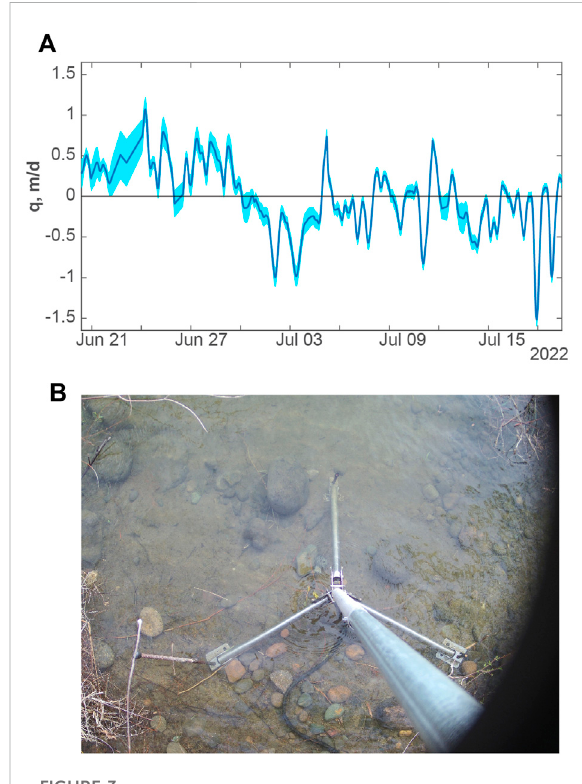
FIGURE 3 (A) AsubsetofERTSS fl uxestimates(darkblueline)asspeci fi c dischargeand95%con fi denceinterval(cyan)showing fl uctuations and reversals in fl ux. Downwelling is positive, and upwelling is negative. The con fi dence interval expands in width in between sample times as a function of sensitivity or changing measurement interval; this is evident during data gaps (e.g., there are several gaps during June 23 – 24). (B) Visual-light image of the IR camera site, collected by the Duo Pro